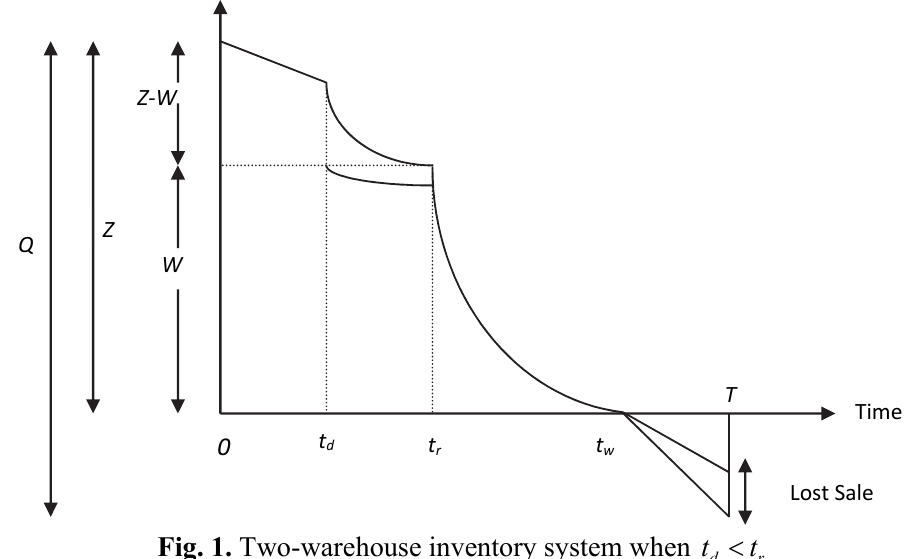
Fig. 1. Two-warehouse inventory system when